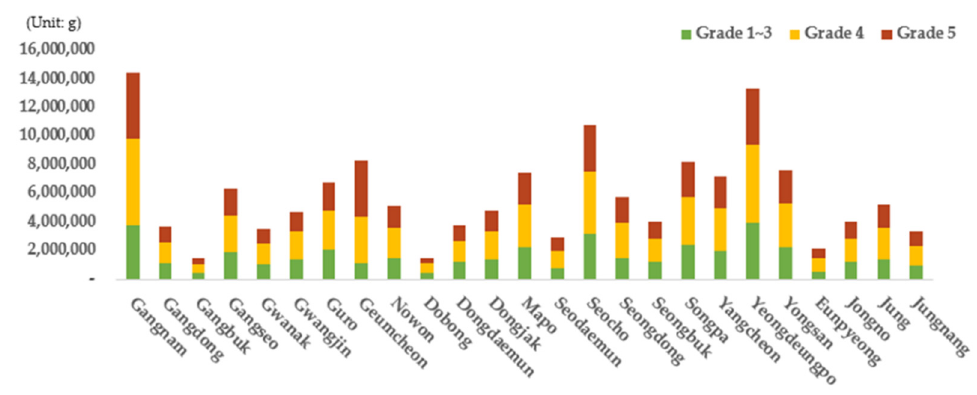
Figure 11. Scenario 1 vehicle emissions by autonomous district ( Gu ) and grade.